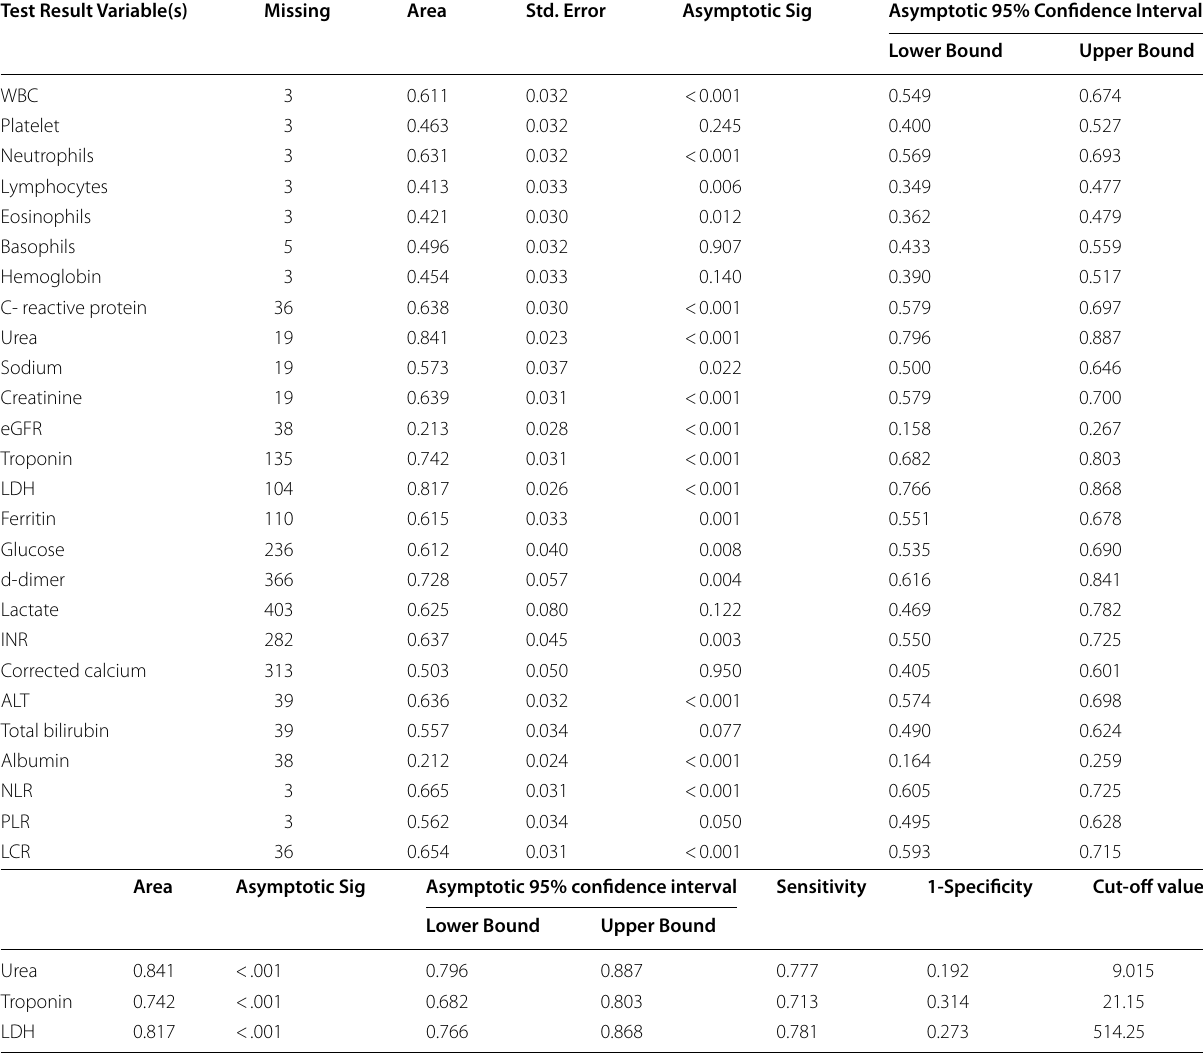
Table 4 Areas under the ROC (AUC) for a number of laboratory parameters Test Result